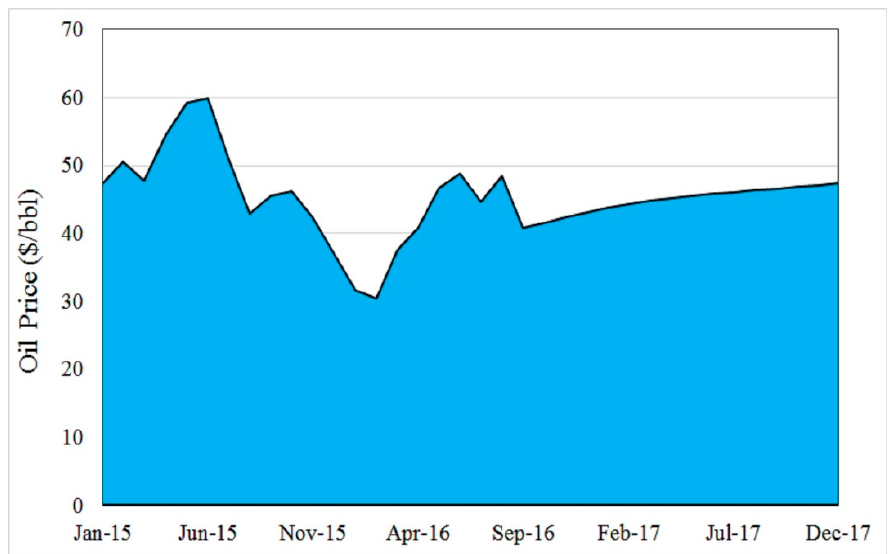
Figure 7. Practical and predicted oil price made by EIA group from January 2015 to December 2017 with the estimation was made from September 2016. Oil price varied from 30 $/bbl to 60 $/bbl during this period.